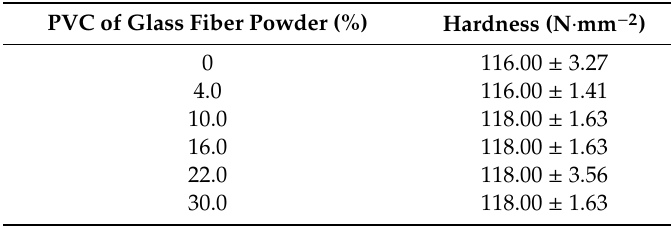
Table 4. Influence of the PVC of glass fiber powder on the hardness of the thermochromic waterborne